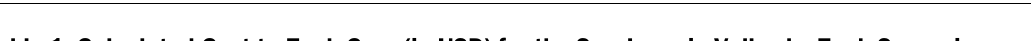
Table 1. Calculated Cost to Each Crop (in USD) for the San Joaquin Valley by Each Scenario Only crops that are have areas in the DWR Land Cover, have crop values in the agriculture commissioner’s reports, and are impacted by at least one growth scenario are